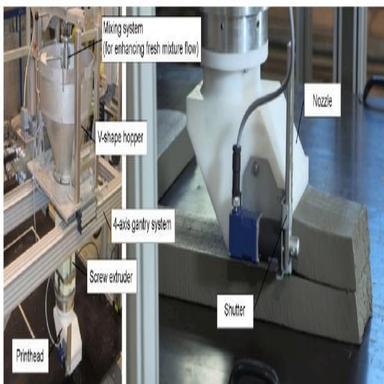
Typical 3DCP experimental setups. (a) TU Delft: 3-axis gantry-based system, multiple batches (material preparation), and rotor-stator-based pump, adapted from Ref. ; (b) TU Eindhoven: 4-axis gantry-based system, continuous mixing (material preparation), and rotor-stator-based pump, adapted from Ref.; (c) XtreeE: 6-axis robotic arm, peristaltic pump, and inline mixing and extrusion printhead (set-on-demand), adapted from Ref.; (d) TU Dresden: 4-axis gantry-based system, multiple b